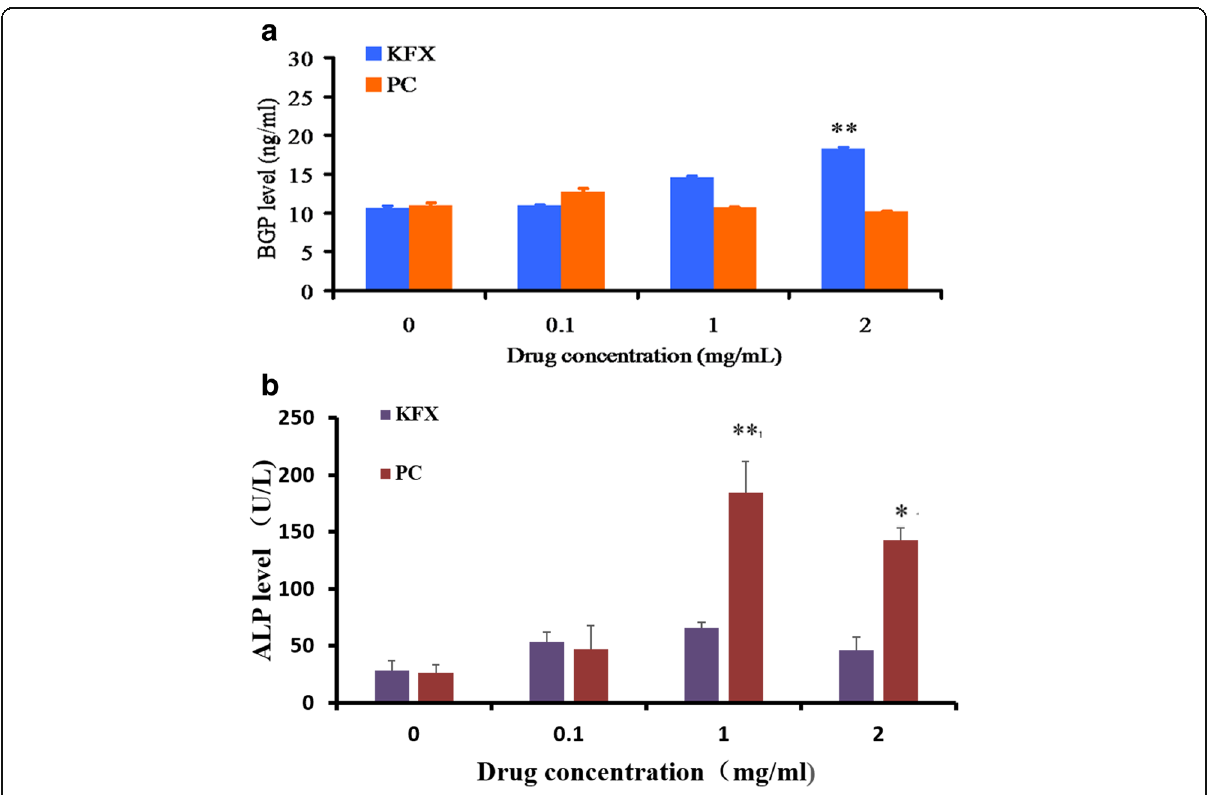
Fig. 3 ( a ) Osteocalcin concentration, and ( b ) ALP activity in osteoblasts incubated with KFX and PC substance were determined. KFX treated group with the concentration of 2 mg/mL exhibit higher BGP level than PC substance. Data from three independent assays are presented as the mean ± SD ( n = 3). Statistical significance was calculated by using t -test, * represents * p < 0.05,** p <